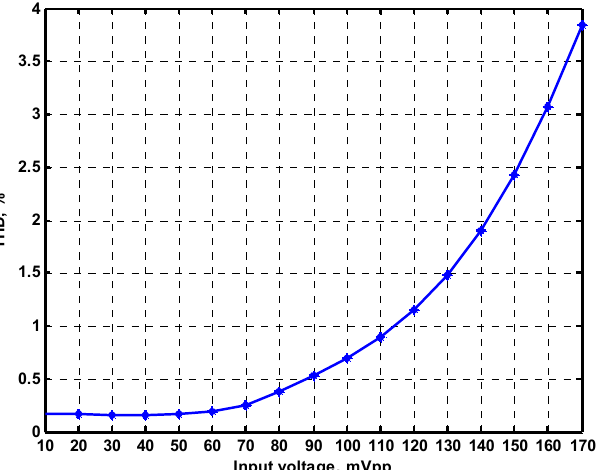
Figure 18. Total harmonic distortion (THD) analysis results of BP response.